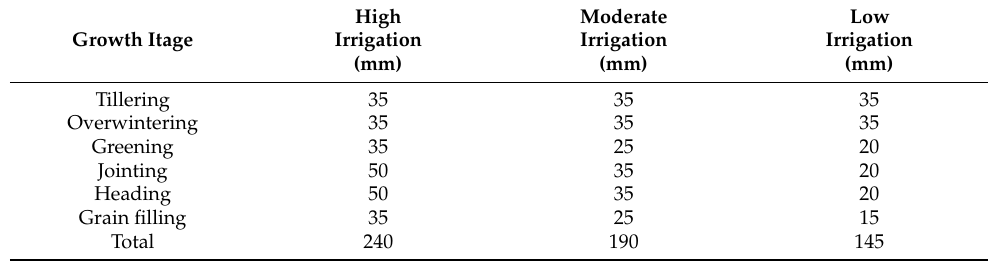
Table 1. Summary of irrigation volumes for the three treatments at six stages of growth for winter wheat. Growth